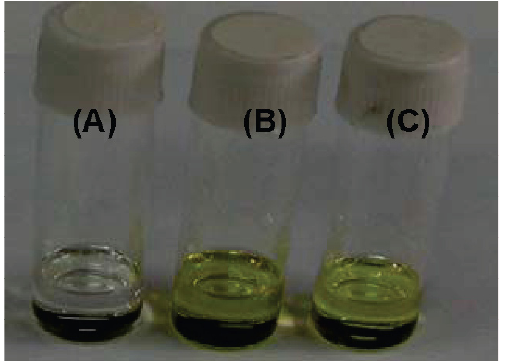
Figure 39. Change in color of 36 (20 μM) (A) upon addition of 2 equiv of adamantane-1-carboxylate (B) and acetate (C) in